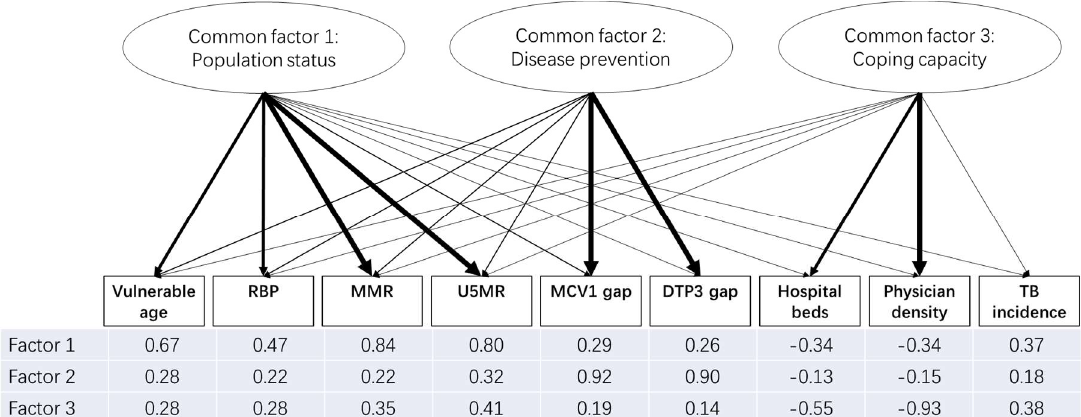
Figure 2. Factor loadings of the three latent factors. Note: Factor loadings are printed under the corresponding indicator. They are also indicated by the thickness of the arrow linking the factor and the indicator: the thicker the arrow, the higher the factor loading. Arrows are not shown if the absolute value of the factor loading is less than 0.2. Vulnerable age: people aged 0–14 or/and 65+ (%); RBP: Age-standardized raised blood pressure prevalence (%); MMR: Maternal mortality ratio (per 100,000 live births); U5MR: Under-five mortality rate (per 1000 live births); MCV1 gap: MCV1 Coverage Gap (%); DTP3 gap: DTP3 Coverage Gap (%); Hospital beds: Hospital beds density (per 10,000 population); Physician density: Physicians density (per 1000 population); TB incidence: Incidence of tuberculosis (per 100,000 population).